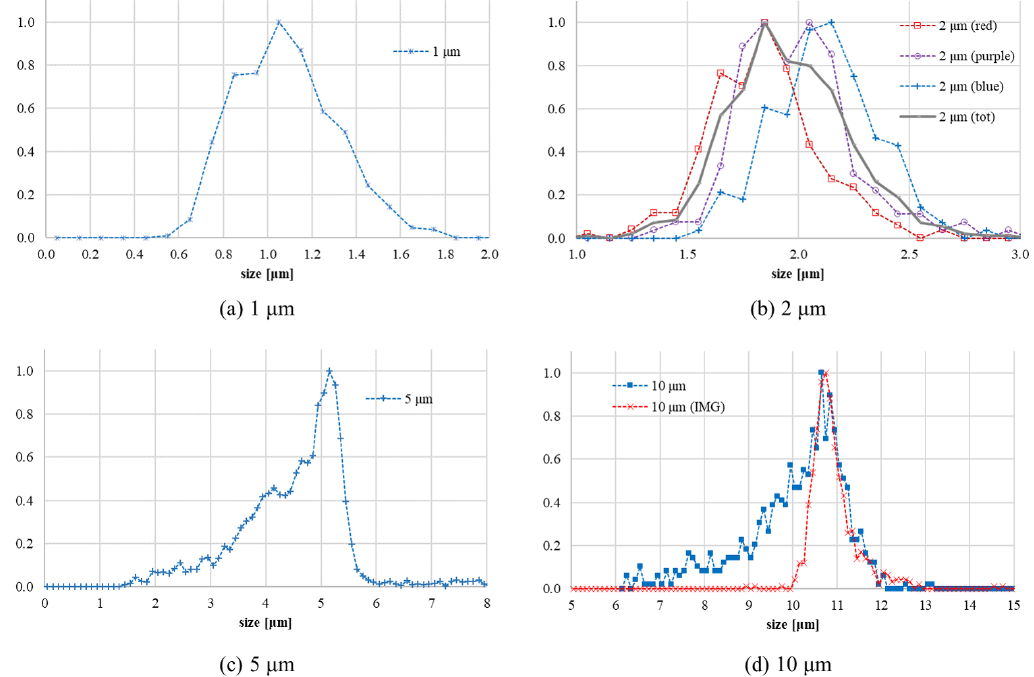
Figure 6. Size distribution estimated by the Swisens Poleno for different PSL particles with diameters ranging from 1–10µm. The estimates were computed based on the trigger laser signal, except for the “10µm (IMG)” curve in (d) , where the image-based method was